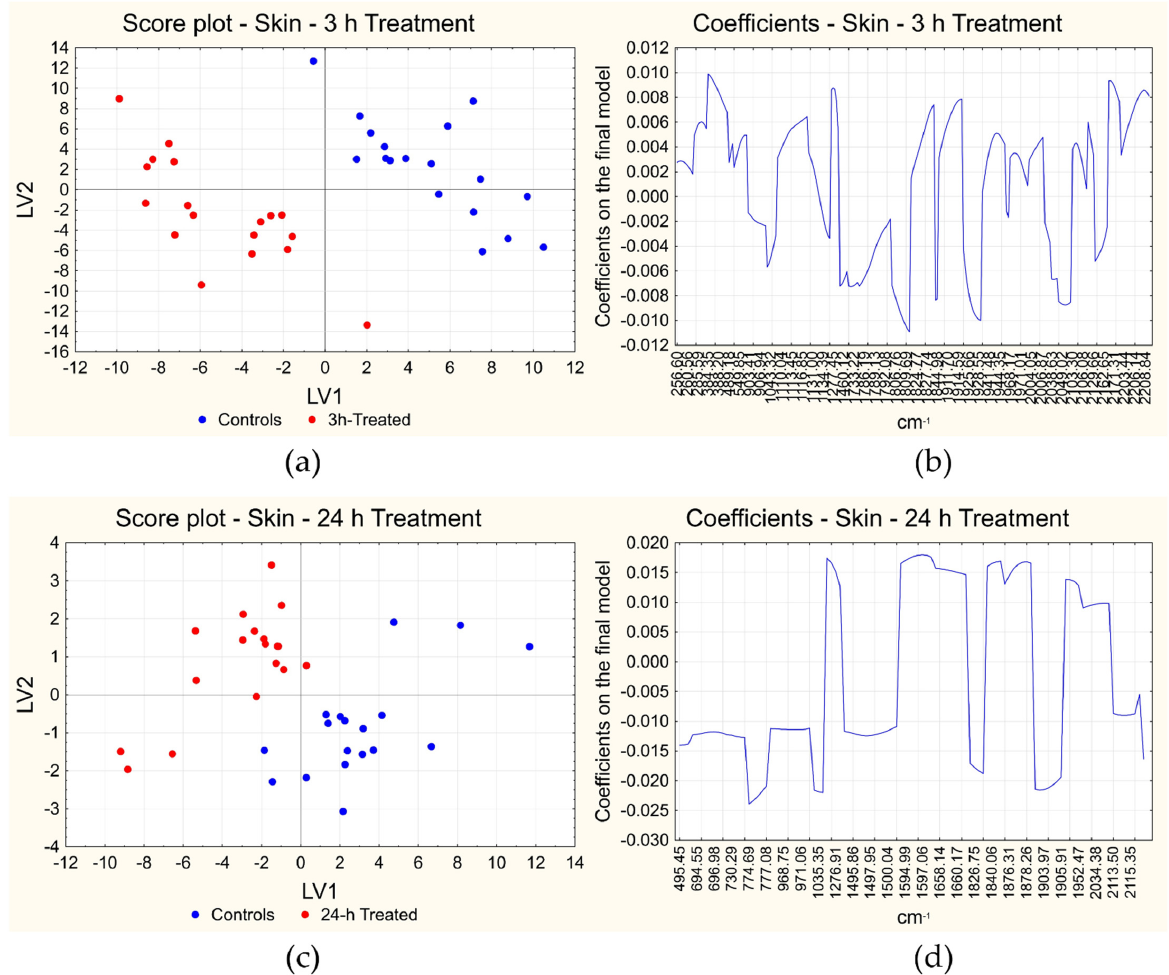
Figure 6. Results of PLS-DA on skin: score plot ( a ) and plot of the coefficients ( b ) of short-term treatment and long-term treatment ( c , d ). The score plots report the scores of each measurement in the space given by the first two latent variables (LVs) calculated, with the samples indicated in blue if they are controls and in red if they are treated samples. The plots of the coefficients report the variables included in the final models on the x-axis and the coefficients on the final model on the y-axis. Positive coefficients correspond to variables with a higher signal in the first derivative of treated samples, while negative coefficients correspond to variables with a lower signal in the same situation.